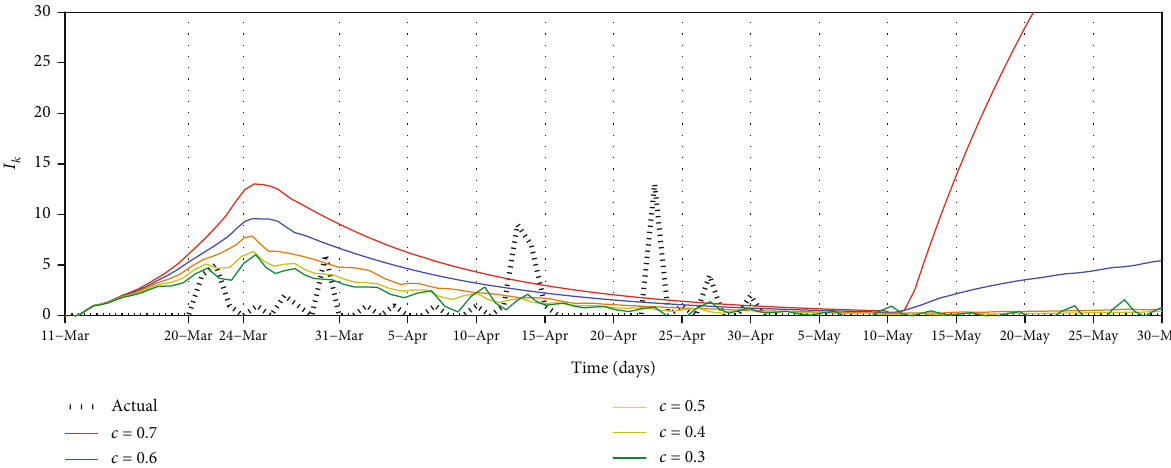
Figure 4: Comparison of actual infected data and simulation results for di ff erent contact rate values in Kalutara district.